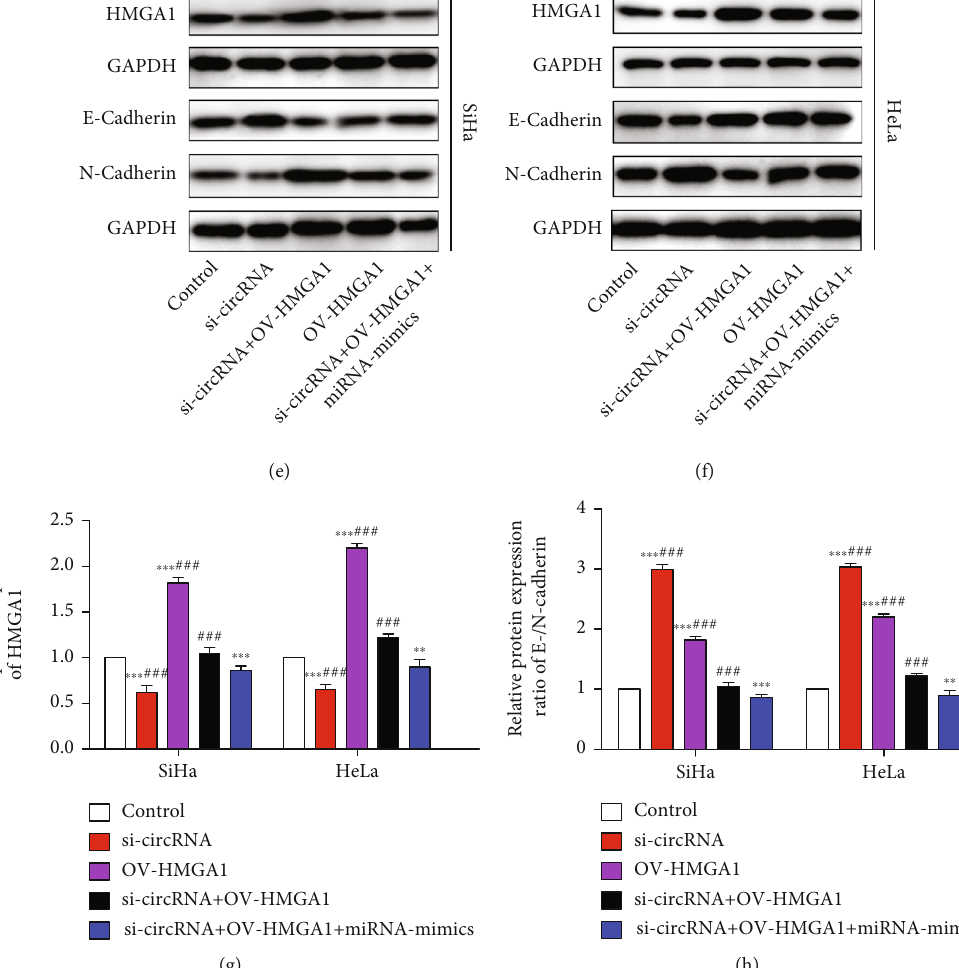
Figure 5: hsa_circ_0000511 promoted EMT by regulating hsa-miR-296-5p/HMGA1 signal. Overexpression of HMGA1 increased the ability of invasion (a) and migration (b) in SiHa and HeLa cells, and the number of cells in the lower Transwell chamber was increased signi fi cantly (c, d). Further, the results of Western blotting (e, f) indicated that the expression of E-cadherin and N-cadherin (h) was consistent with that of HMGA1 (g). Overexpressed HMGA1 inhibited the protein expression of E-cadherin and promoted that of N-cadherin, and vice versa. Mean ± SD ; the data were analyzed by one-way analysis of variance; vs. control, ∗∗ p < 0 : 01 and ∗∗∗ p < 0 : 001 ; vs. si-circRNA+OV- HMGA1+miRNA mimics, ### p < 0 : 001